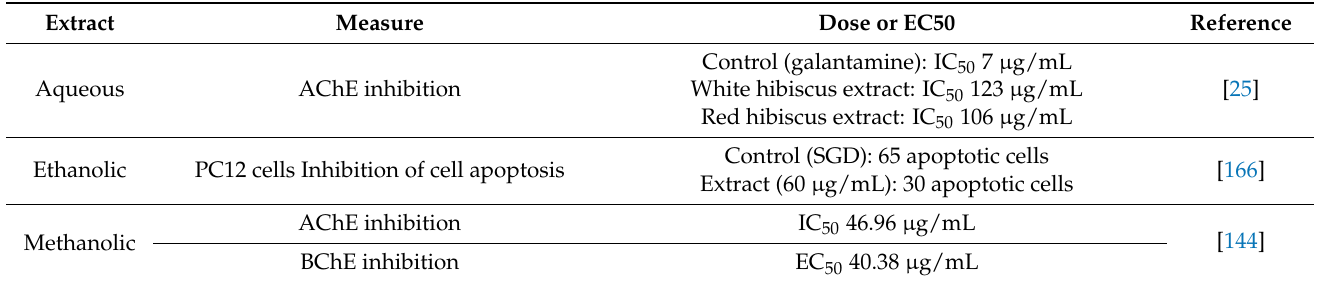
Table 5. In vitro neuroprotective effect of aqueous, ethanolic, and methanolic H. sabdariffa